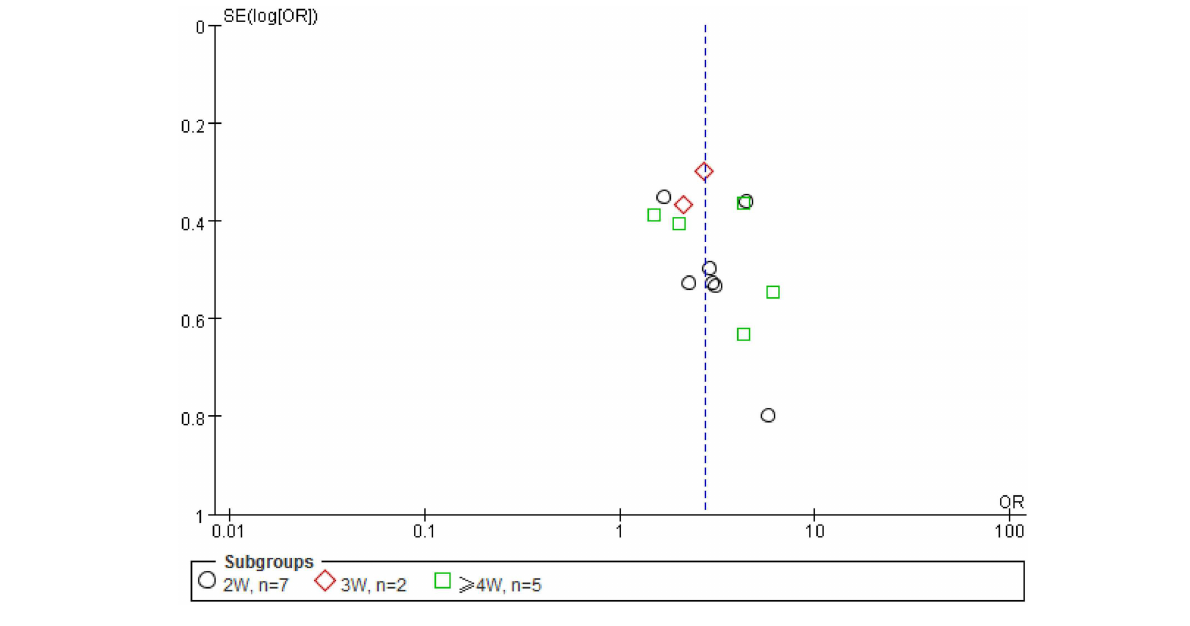
FIGURE 8 |A funnel plot was made using the data of effectiveness rate (ER) . A total of 13 trials reported the effect rate, which was categorized into three subgroups by the evaluating time: (1) 7 trials assessed the ER at the end of 2weeks of treatment, (2) 2 trials assessed